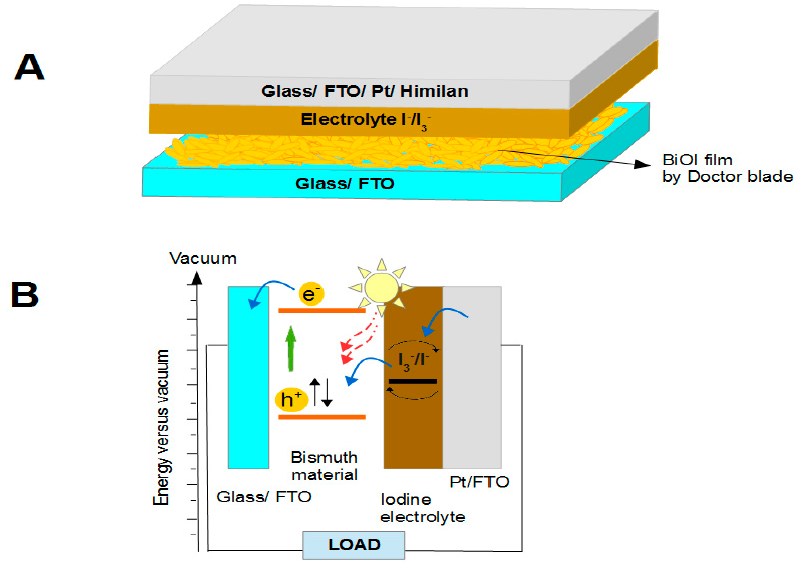
Figure 5. Device structure ( A ) and band structure illustration of annealed BiOI in di ff erent temperatures ( B ).